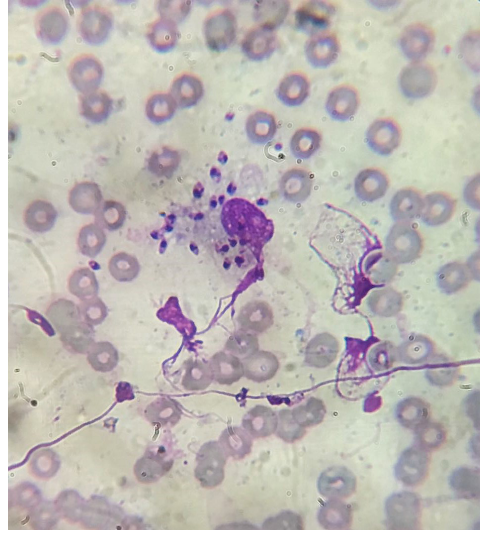
Figure 1. Ear tip cytology stained with Rapid Panoptic Staining presenting Leishmania spp. in the macrophages’ cytoplasm, amplification of 1000x.